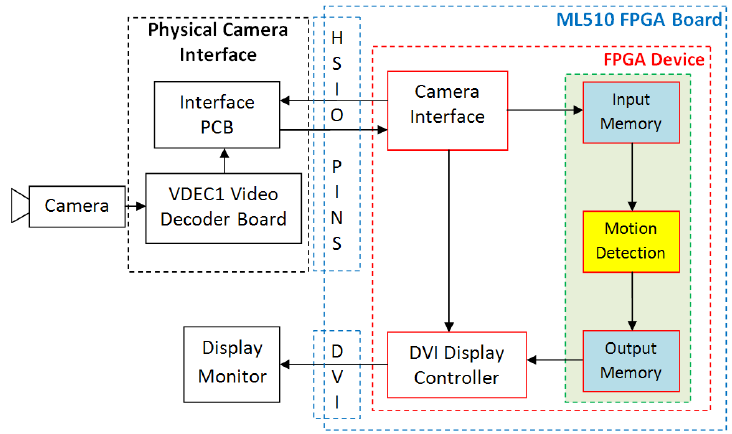
Figure 3. Dataflow Diagram of the Proposed and Developed Motion Detection System.